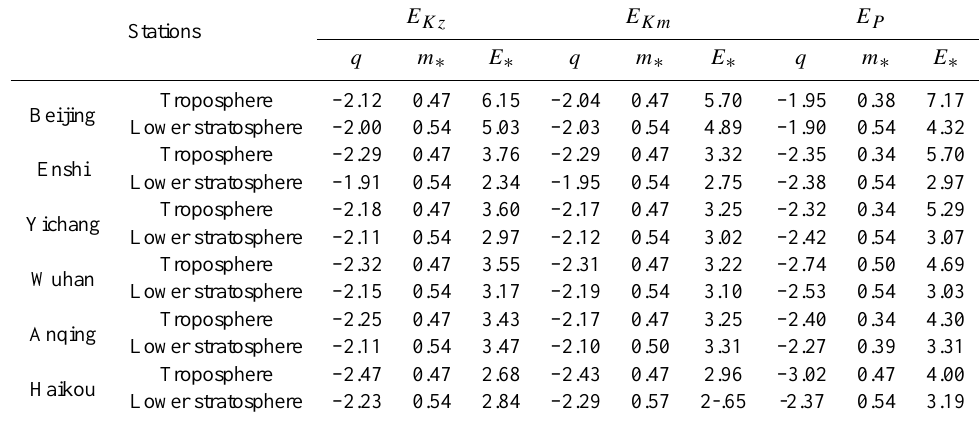
Table 4. Parameters of vertical wave number spectrum for GWs over different stations.